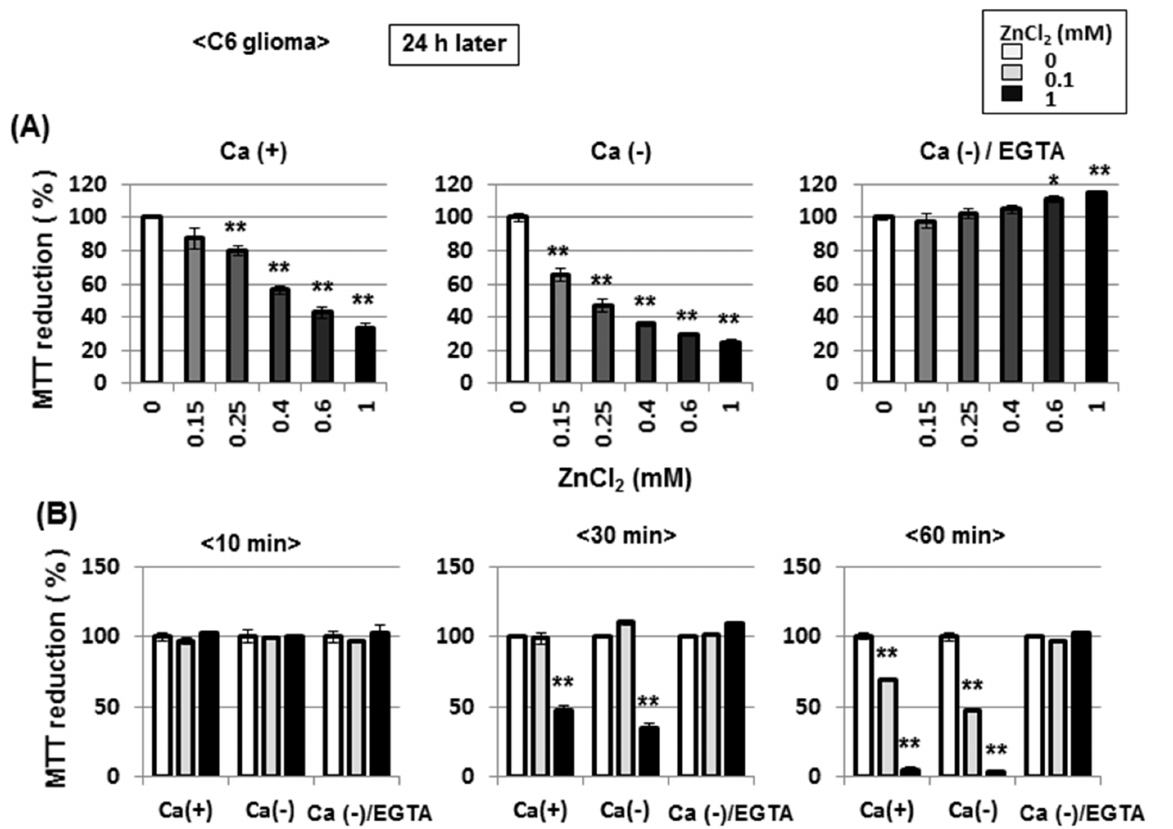
Fig 14. Effects of EGTA on ZnCl 2 -induced inhibition of MTT reducing activity in C6 glioma cells. (A) Cells were exposed to ZnCl 2 at concentrations of 0.15 to 1 mM in either the presence or absence of CaCl 2 and EGTA for 1 h, followed by culture for an additional 24 h and subsequent determination of MTT reducing activity. (B) Cells were also exposed to ZnCl 2 at 0.1 or 1 mM in either the presence or absence of CaCl 2 and EGTA for different periods from 10 to 60 min, followed by culture for an additional 24 h and subsequent determination of MTT reducing activity. Values are the mean ± S.E. of percentages over the maximal activity detected in cells not exposed to any test chemicals in 3 different experiments. * P < 0.05, ** P < 0.01, significantly different from the control value in cells not exposed to ZnCl 2 .